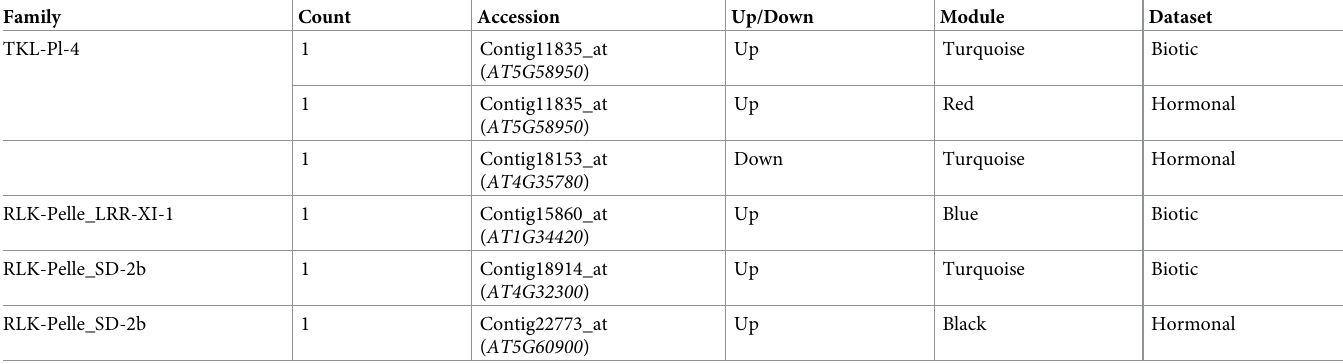
Table 4. PKs identified in biotic and hormonal treatment